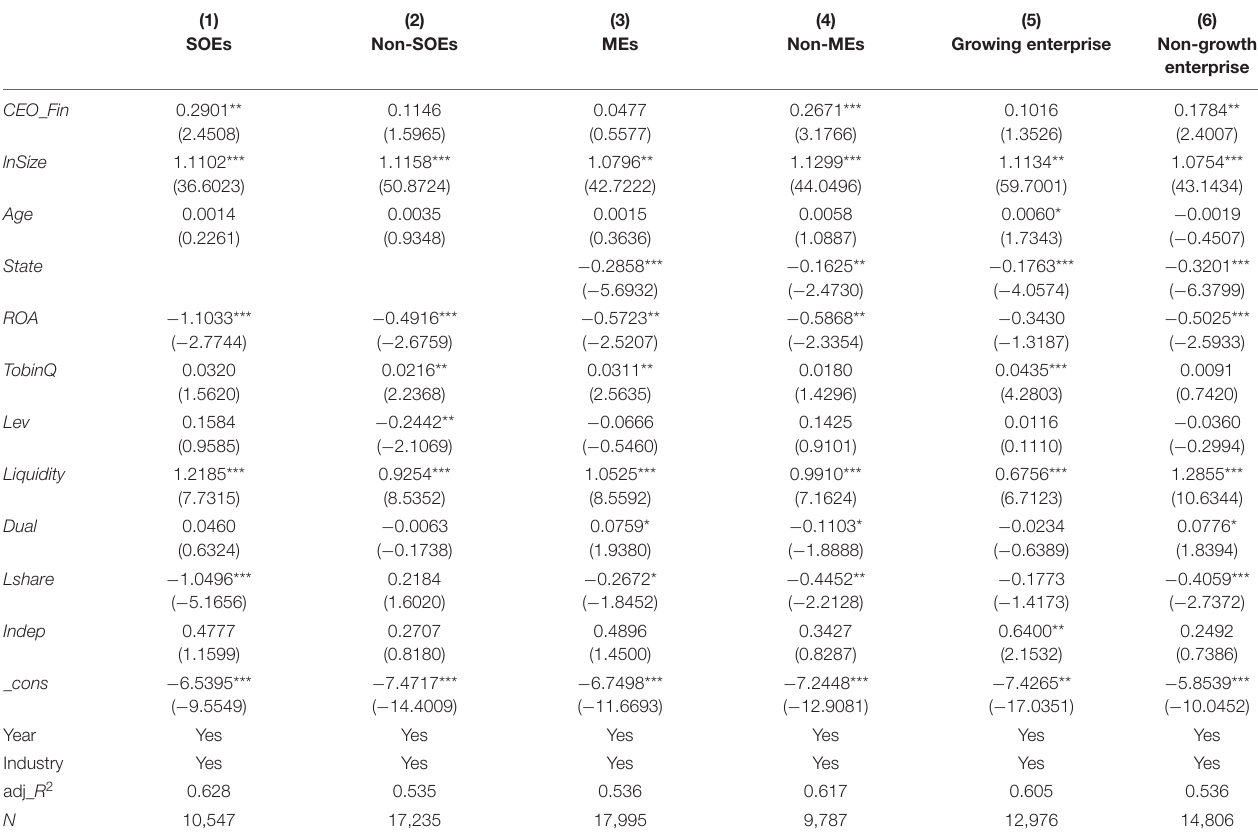
TABLE 8 | CEOs’ FB and shadow banking business of non-financial enterprises: internal micro characteristics of